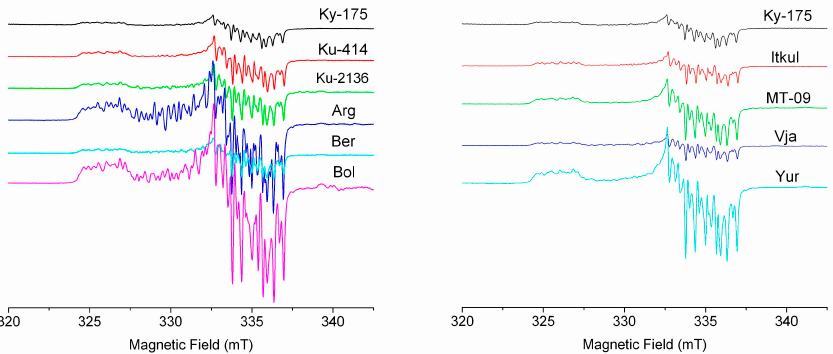
Figure 8. EPR spectra of investigated quartz samples taken at 85 K showing varying quantities of the [AlO 4 ] 0 centre.